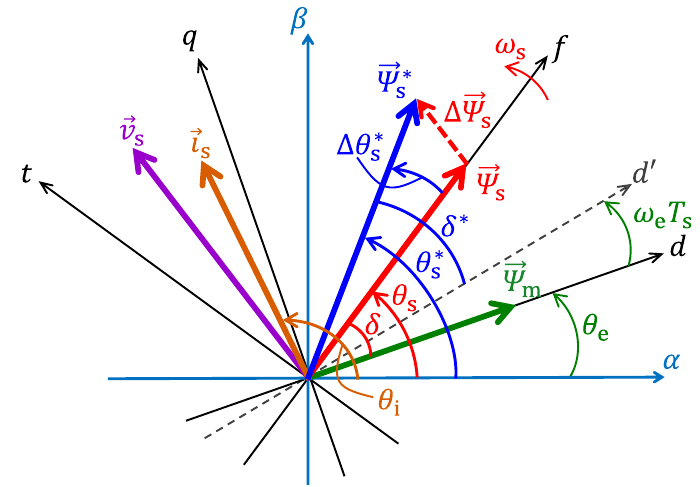
Figure 1. Phasor diagram used in analysis of IPMSM drive.